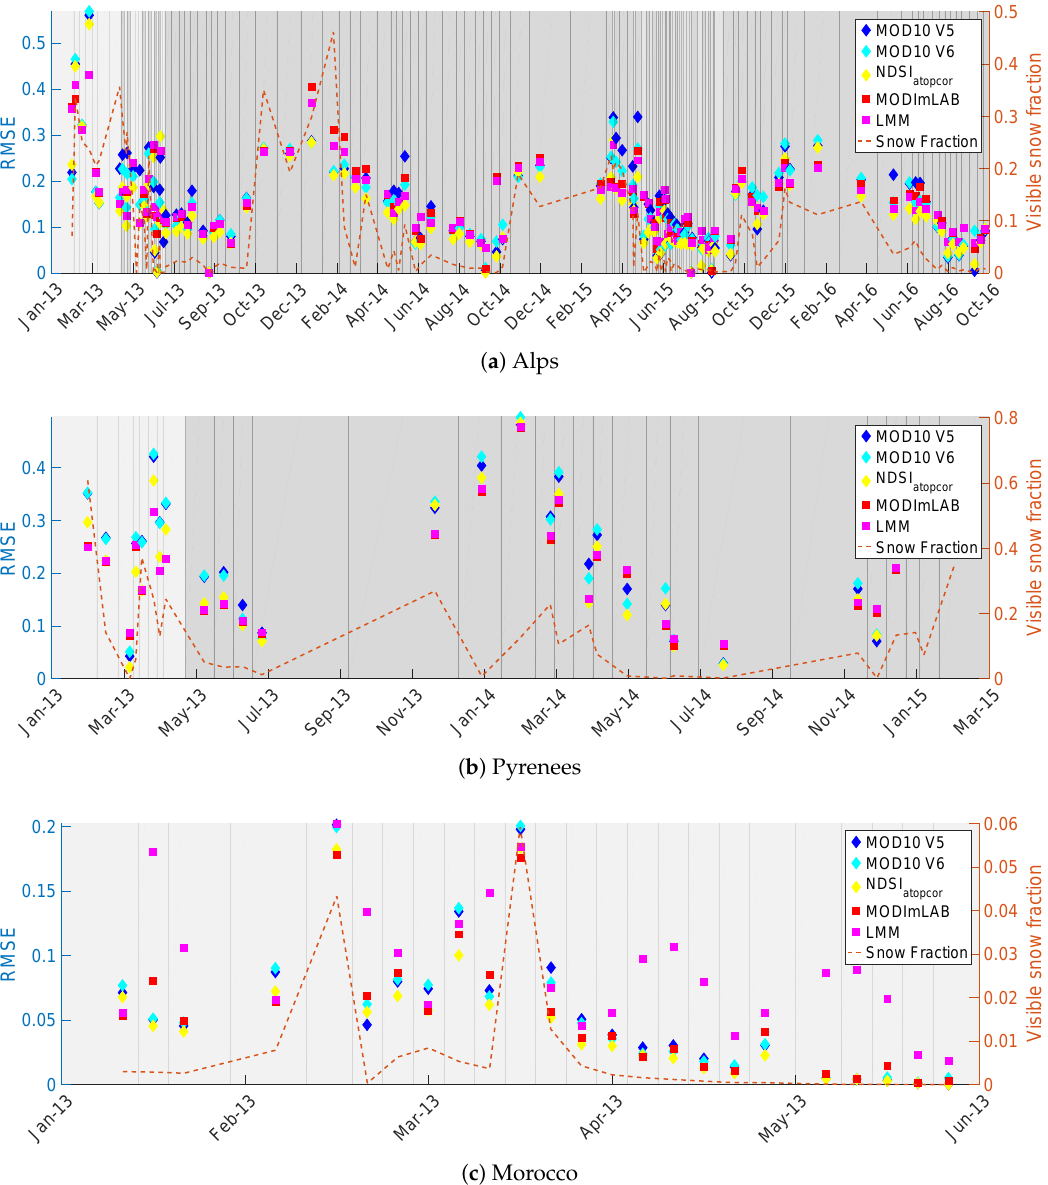
Figure 3. Root mean square error (RMSE) (markers) and total snow cover fraction (orange line) over all non-cloudy pixels over the Alps ( a ), Pyrenees ( b ), and Moroccan Atlas ( c ), as a function of all the available dates in each area. Square markers represent SU approaches and diamond-shaped markers represent NDSI approaches. The color of the background corresponds to the sensor used as reference. The lighter grey represents SPOT 4, the medium grey SPOT 5, and the darker grey